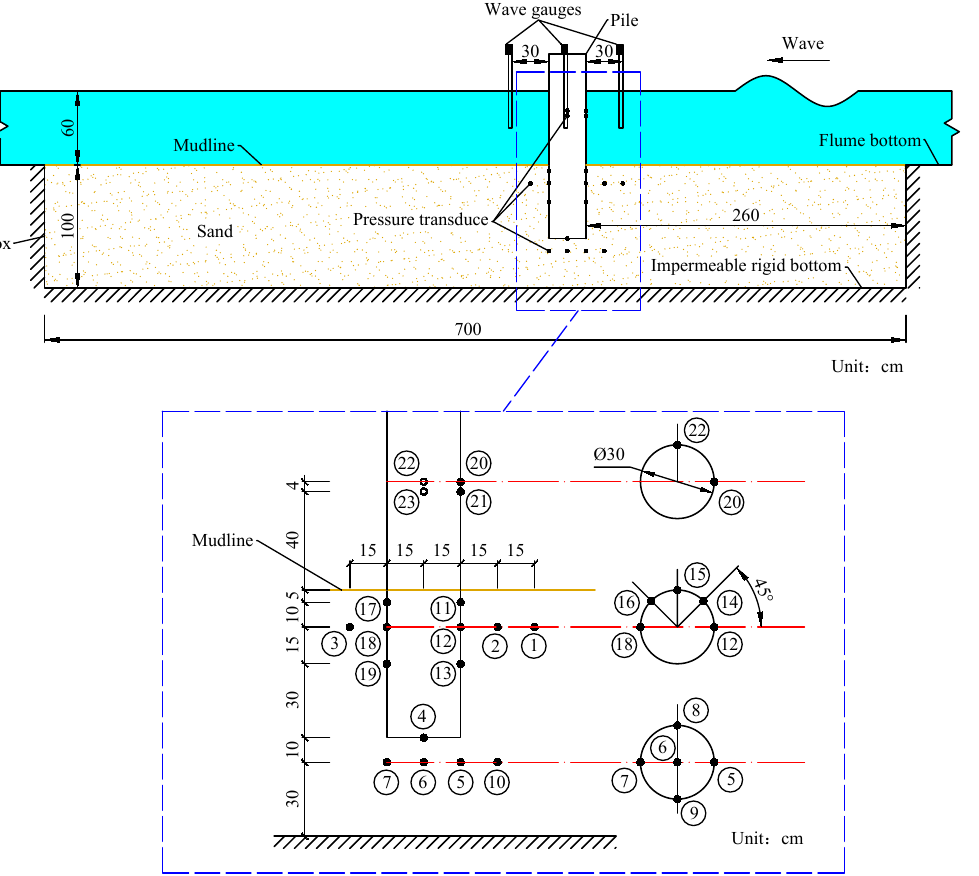
Figure 3. Locations of pressure